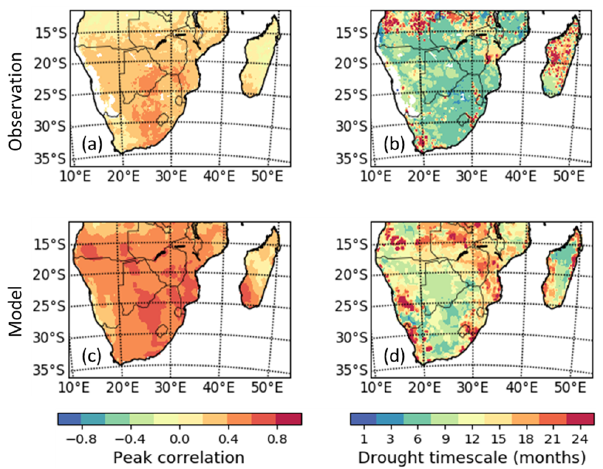
Figure 7. Spatial distribution of peak correlation between drought (SPEI) and LAI over the region of southern Africa in the observation and in the model ensemble median for the period 1982– 2011. Panels (a) and (c) show the peak correlation per pixel, which is independent of the timescale and the month of the year. Panels (b) and (d) indicate the timescales at which the peak correlation be- tween SPEI and LAI is found. Areas with no significant correlation are